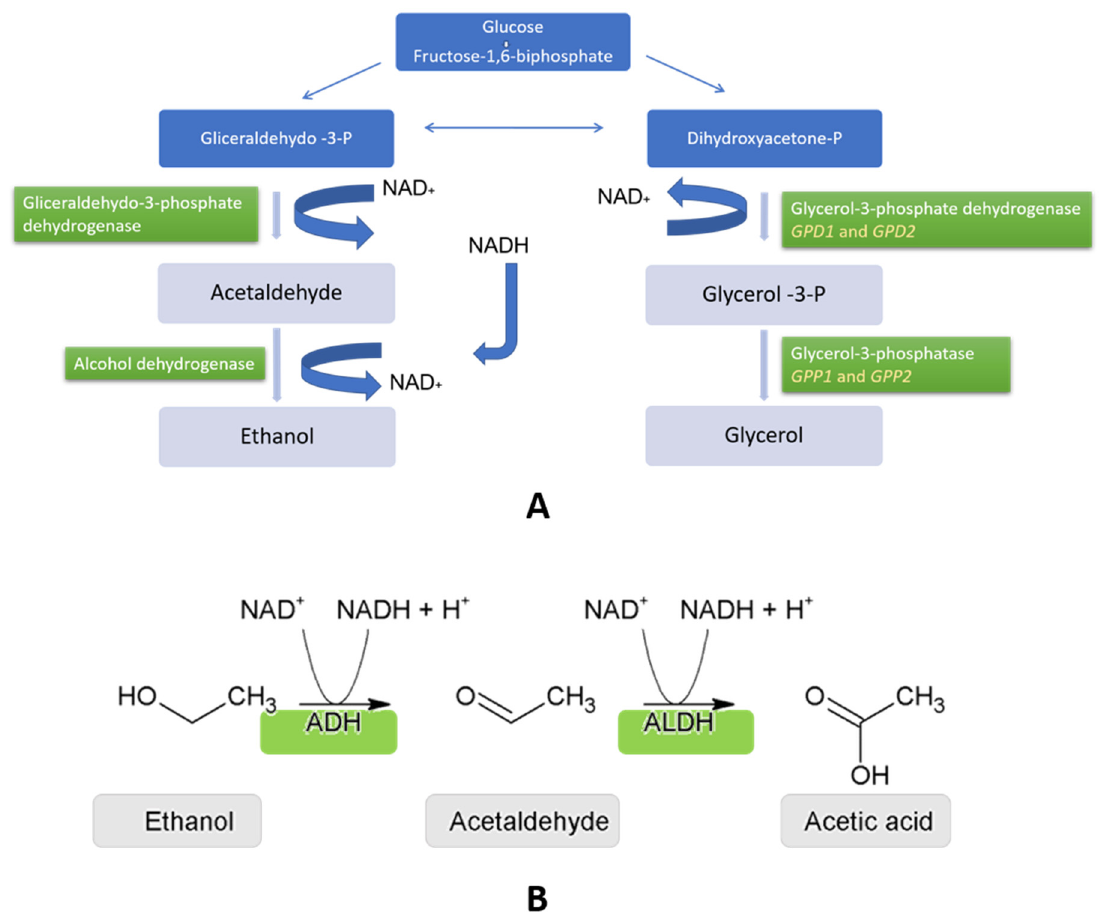
Figure 5. ( A ) Biochemical pathways leading to the production of glycerol (taking place in the cell cytosol) results in a depletion of the NADH cofactor. ( B ) Aldehyde dehydrogenases (ALDH) (converting acetaldehyde to acetic acid) are implicated in replenishing the NADH levels as higher acetic acid levels are observed with GPD1 overexpression.